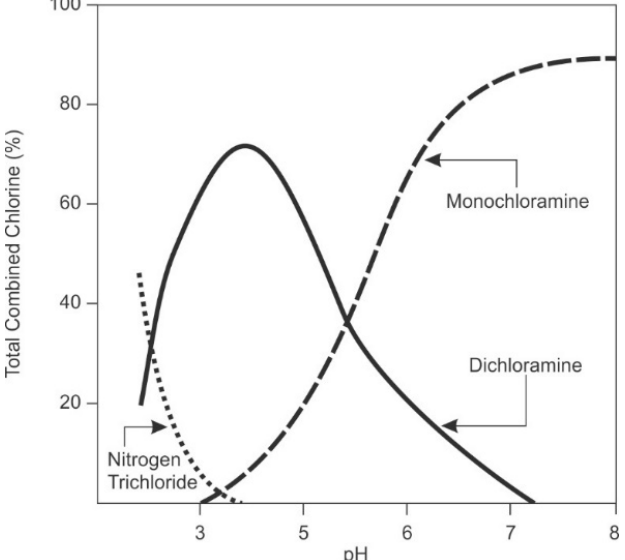
Figure 8. Combined chlorine as a function of pH. Nitrogen trichloride (trichloramine) is only present at pH less than about 3.5; dichloramine predominates at pH ranging from about 2–5.5; and monochloramine is the predominant species at pH greater than about 5.5.